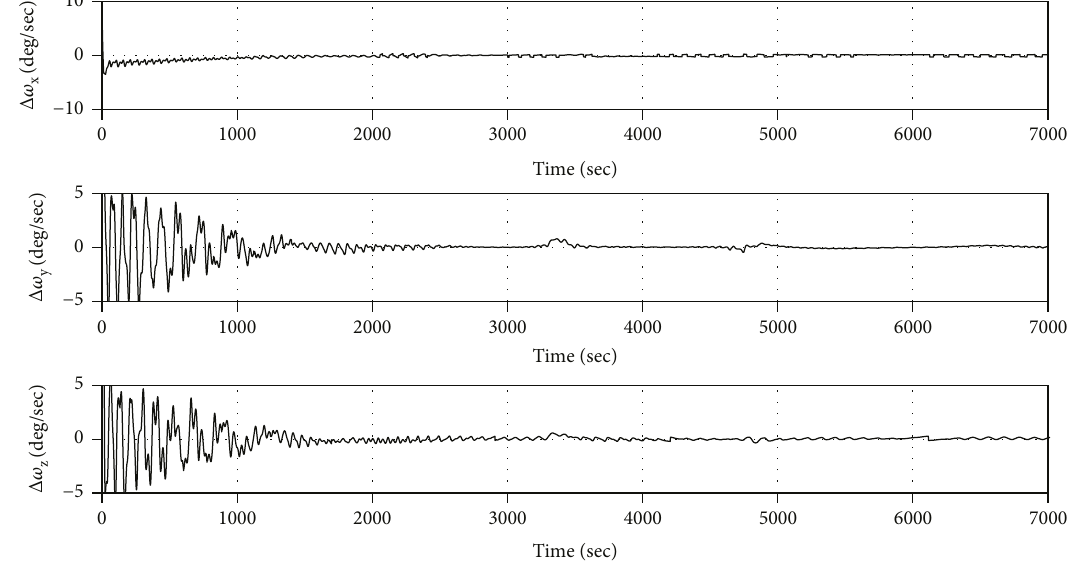
Figure 8: Di ff erence between actual and measured angular rates ( ω